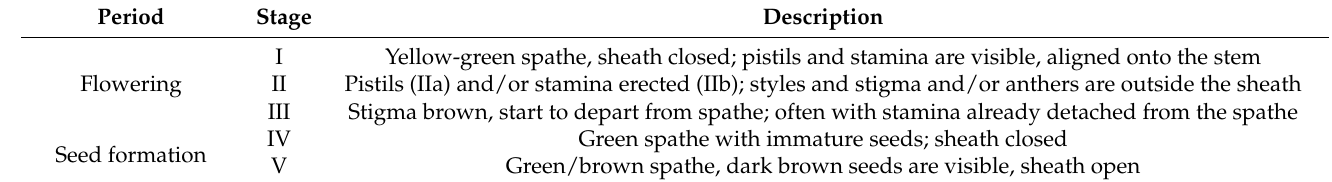
Table 1. Description of the five sexual reproductive stages used to study the reproductive phenology of Z. noltei in Ria de Aveiro. The morphology of each reproductive stage is shown in Figure 2.